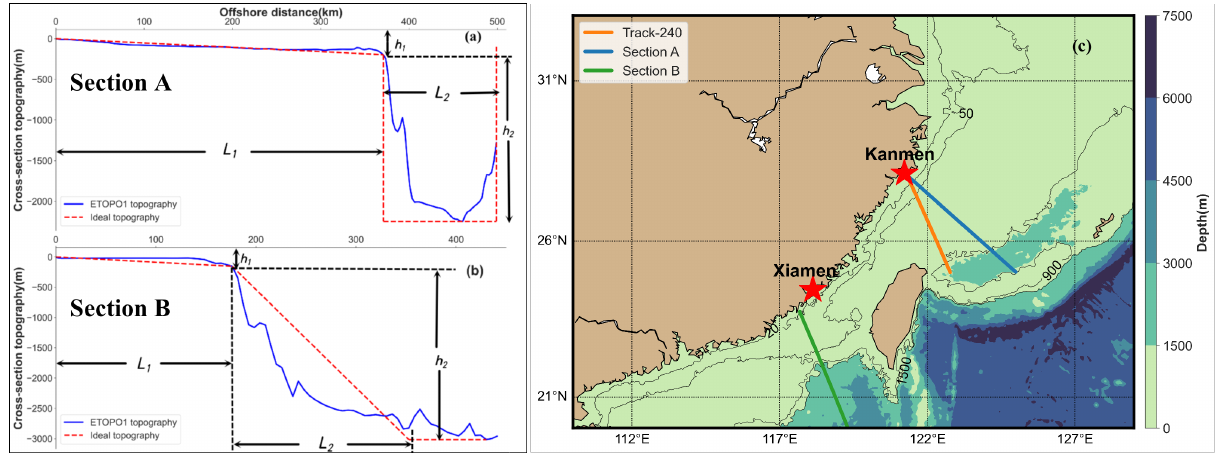
Figure 2. The cross-section topography for estimating the propagation speed of the coastally trapped wave. The ETOPO1 and simplified topography of ( a ) Section A in the East China Sea, ( b ) Section B in the South China Sea; ( c ) the blue line represents the position of the topographic section of the East China Sea; the green line represents the position of the topographic section of the South China